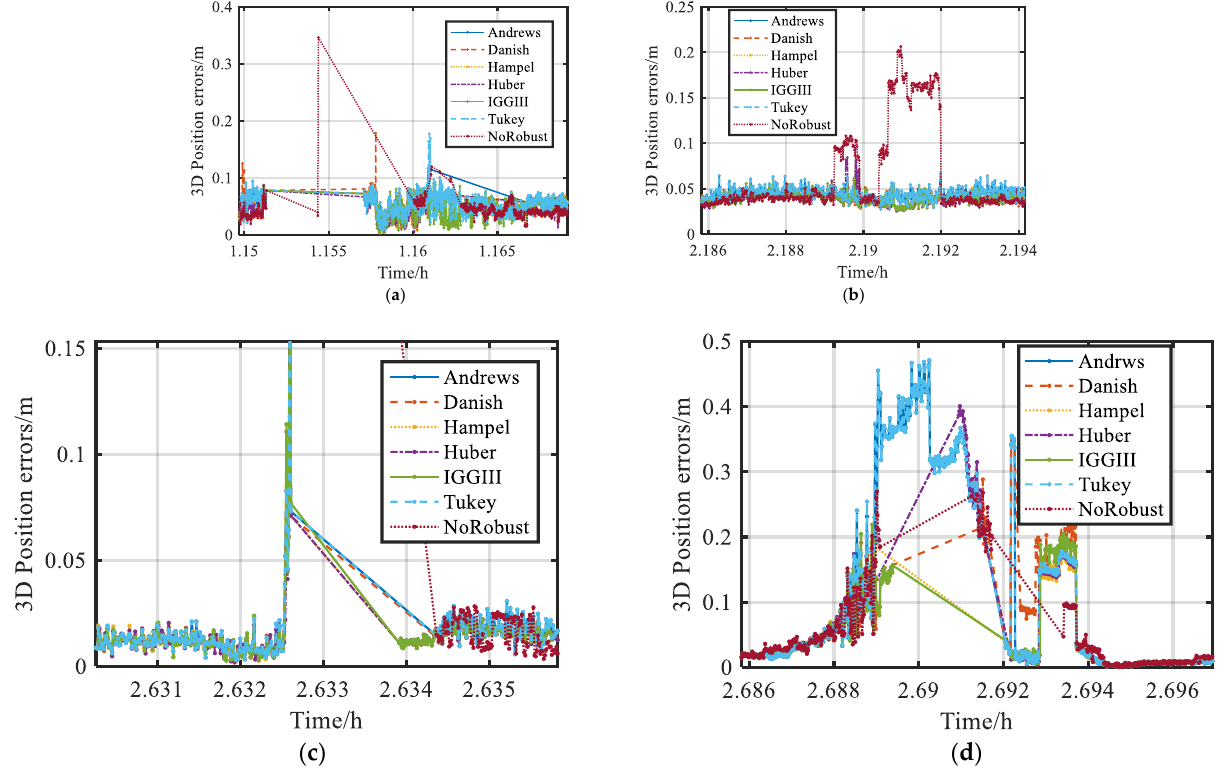
Figure 11. The 3D position errors of blocked environments of different schemes: ( a ) signal interference area; ( b ) densely built area; ( c ) viaduct area; ( d ) tall porch area.